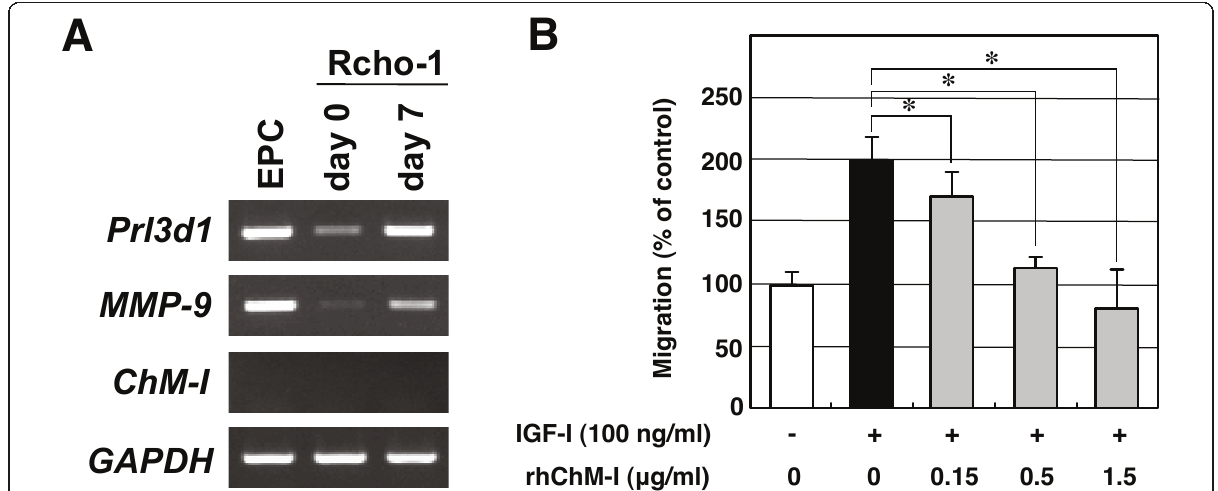
Figure 7 Effects of rhChM-I on the IGF-I-induced migration of Rcho-1 trophoblast cells . (A) Expression of Prl3d1, MMP-9 , and ChM-I in Rcho-1 trophoblast cells. Rcho-1 trophoblast cells were seeded at 2 × 10 5 cells/well in 6-multiwell plates and cultured in growth medium (NCTC-135 medium containing 20% FBS) until reaching confluence (day 0; undifferentiated). The culture medium was then replaced with differentiation medium (NCTC-135 medium containing 10% horse serum), and the cells were cultured for seven days (day 7, differentiated) to promote their differentiation to trophoblast giant cells. EPCs were isolated at 7.5 days p.c. and cultured for two days in DMEM containing 10% FBS and 15 mM HEPES. Total RNA was then isolated and reverse-transcribed, and the expression of Prl3d1 (28 cycles), MMP-9 (28 cycles), and ChM-I (35 cycles)